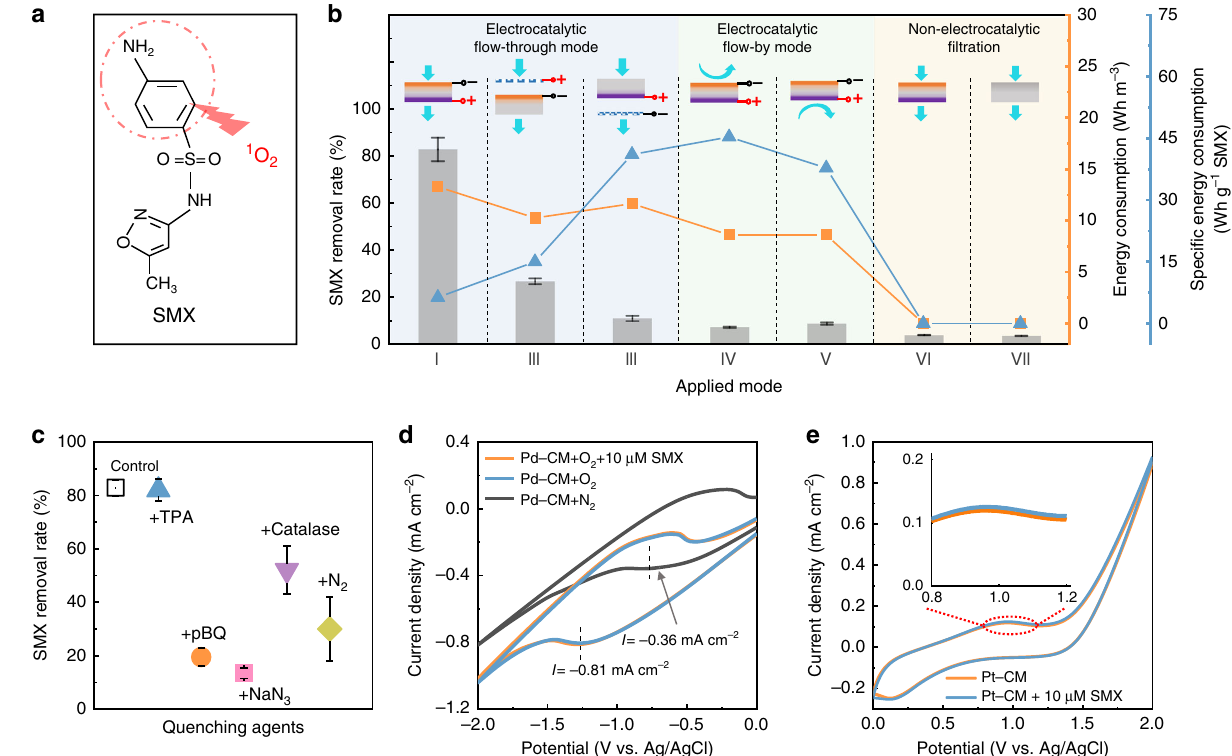
Fig. 3 Effectiveness and energy ef fi ciency of 1 O 2 in situ generated by the Pd – Pt – CM. a Schematic illustrating the reaction between 1 O 2 and SMX. b SMX removal ef fi ciency and electric energy consumption by Pd – Pt – CM under different electrocatalytic and conventional fi ltration modes. Modes I – III are for fl ow-through electro fi ltration. For mode, I, the Pd – CM and Pt – CM surfaces of the Pd – Pt – CM serve as cathode and anode, respectively. Modes II and III apply each side of the Pd – Pt – CM as the cathode (mode II) or anode (mode III) and a Ti mesh plate as the counter electrode inserted in the feed chamber (mode II) or permeate chamber (mode III). Modes IV and V are electrocatalytic fl ow-by modes using the Pd- and Pt-functionalized surfaces as the cathode and anode, respectively. The reaction times of modes IV and V are the same as the fi ltration duration in mode I (i.e., 38 min). Mode VI and VII are conventional fi ltration modes using Pd – Pt – CM and CM without applying voltage. For each fi ltration mode, the feed solution contains 10 μ M SMX and 100 mM Na 2 SO 4 . Error bars represent the standard deviation from triplicate experiments. In the schematic above each bar, the orange layer and purple layer represent Pd – CM and Pt – CM surfaces, respectively, and the blue arrows denote the direction of water fl ow. c ROS quenching by applying 10 mM Measurements were performed in mode I with the respective quenching agent in the feed solution. Error bars represent the standard deviation from triplicate experiments. d CV curves of the Pd – CM surface in 100 mM Na 2 SO 4 electrolyte at a scan rate of 0.1 V s − 1 . e CV curves of the Pt – CM surface